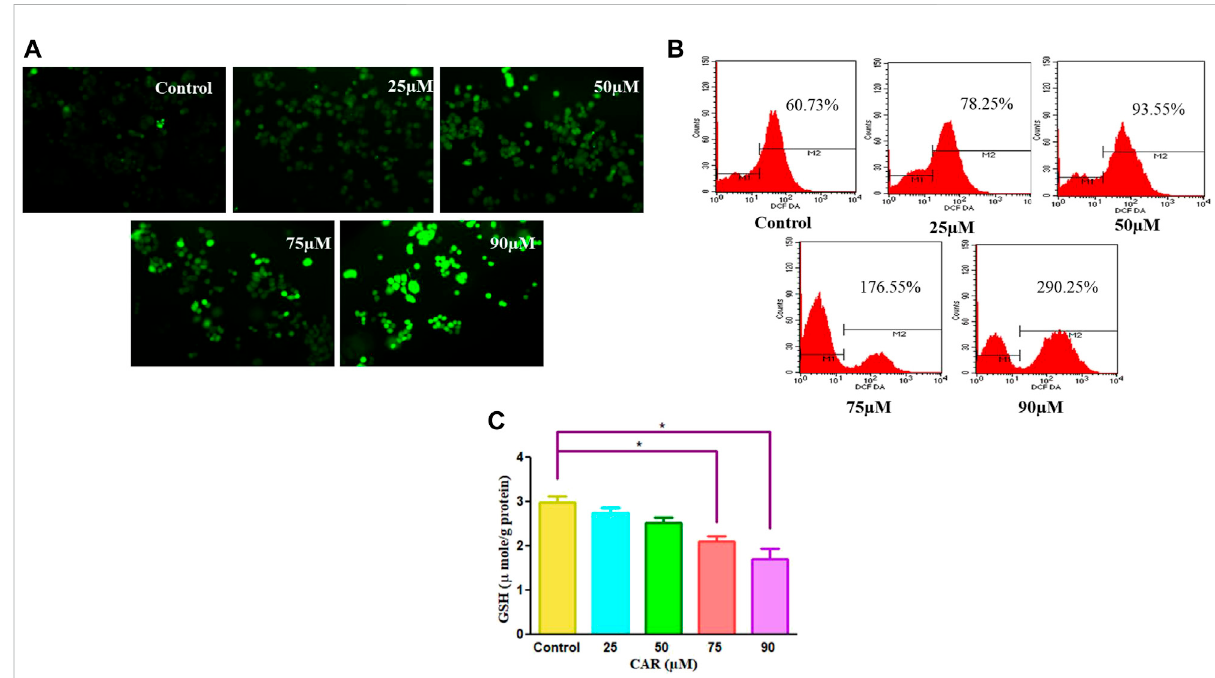
FIGURE 2 CAR mediates the generation of ROS in cervical cancer cells. (A) Fluorescence photomicrographs exhibiting ROS in CAR-treated C33A cells stainedwithDCFH-DAdye (B) Flowcytometricrepresentationofaugmented levelsofDCFH-DAdyedenotingROSgeneration (C) Percent(%)mean fl uorescence intensity (MFI) of DCFHDA-stained after treatment with various concentrations of CAR (25 – 90 µM). Fluorescent micrographs were capturedat×20 magni fi cation[scalebar=100 µm].Eachvalueinthebargraphrepresentsthemean±SEM ofthree independent experiments. Signi fi cant difference among the treatment groups were analyzed by one-way ANOVA followed by Dunnett post hoc test (** p < 0.05 represent signi fi cant difference compared with